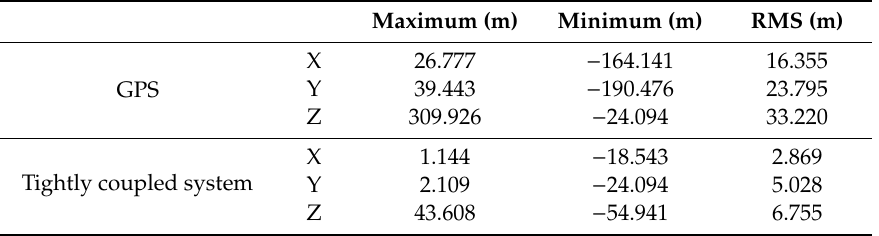
Figure 15. The position error of the tightly coupled system. Table 4. The statistical results of position errors of GPS and the tightly coupled system.